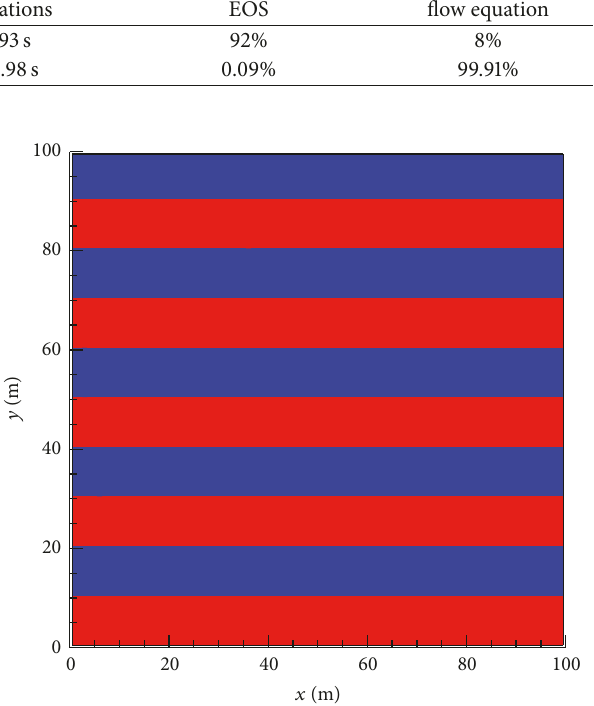
Figure 8: Real gas flow in a more realistic reservoir.